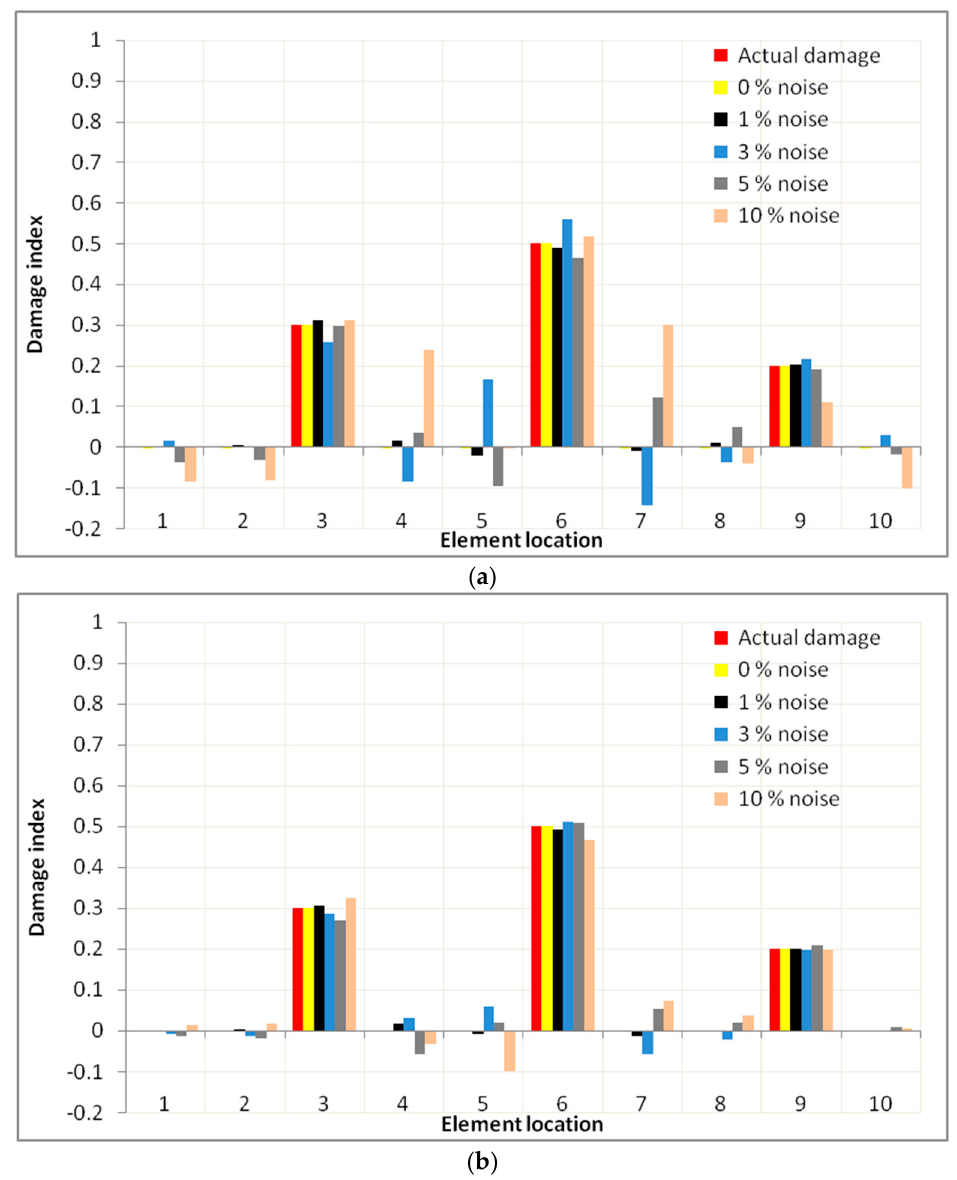
Figure 9. Damage distribution for Case 2 using Objective Function I for ( a ) noise both in frequency and mode shapes and ( b ) noise in mode shapes only.